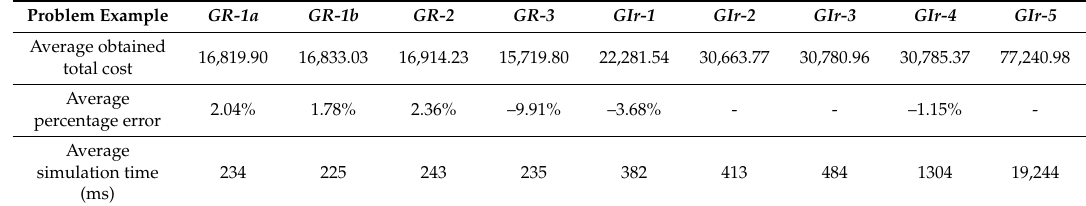
Table 13. Summary of obtained results.